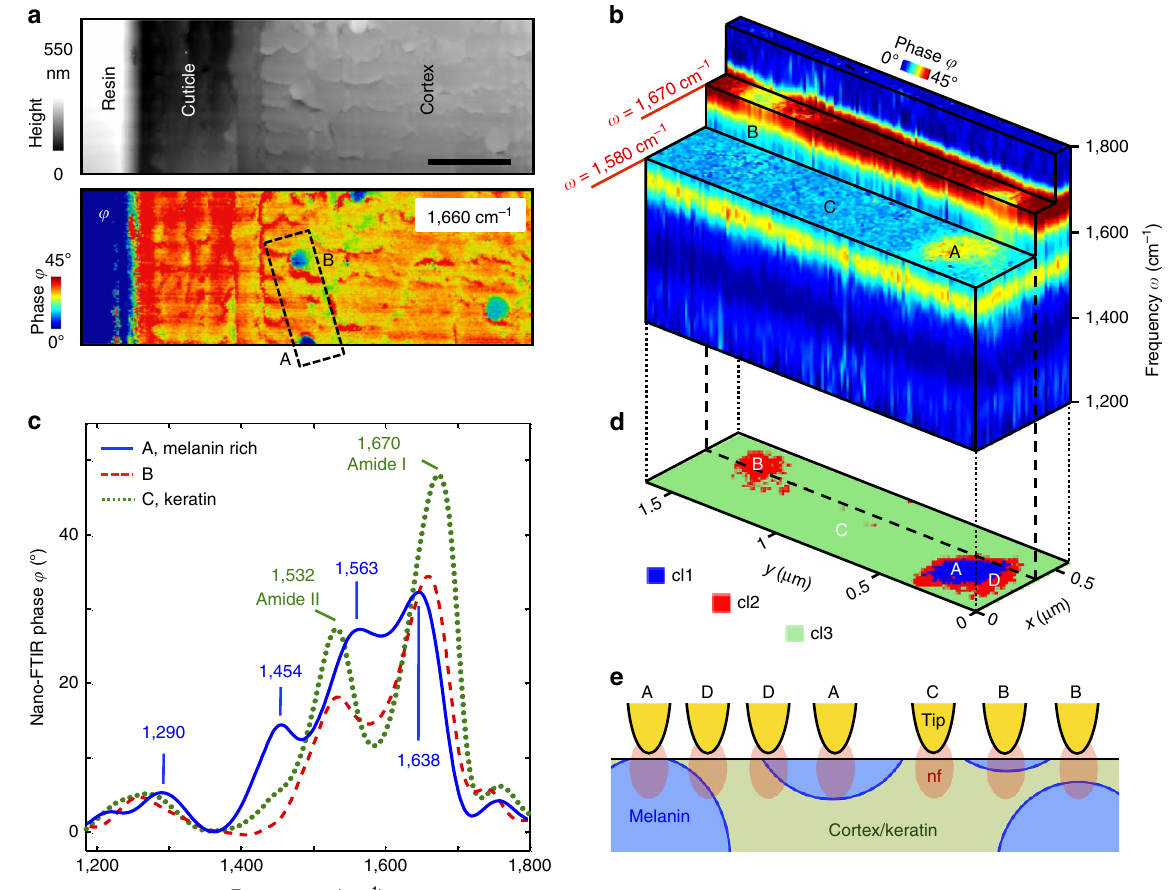
Figure 4 | In situ hyperspectral infrared nanoimaging of native melanin in human hair. ( a ) Top: Topography of a resin-embedded human hair microtome cross-section. Bottom: Infrared near-field phase image j at 1,660cm (cid:2) 1 . Scale bar, 1 m m. ( b ) Hyperspectral infrared data cube with a spectral resolution of 35cm (cid:2) 1 partially cut at different frequencies o . It shows the phase of the tip-scattered light as a function of position ( x , y ) and frequency o . The dashed black rectangle in a shows the area where the data cube was recorded. ( c ) Nano-FTIR spectra (average over nine neighbouring pixels) at positions marked by A, B and C in a , b and d , extracted from the data cube shown in b . ( d ) Cluster map obtained by multivariate data analysis (HCA algorithm). ( e ) Schematics of near-field probing at positions A–D marked in d